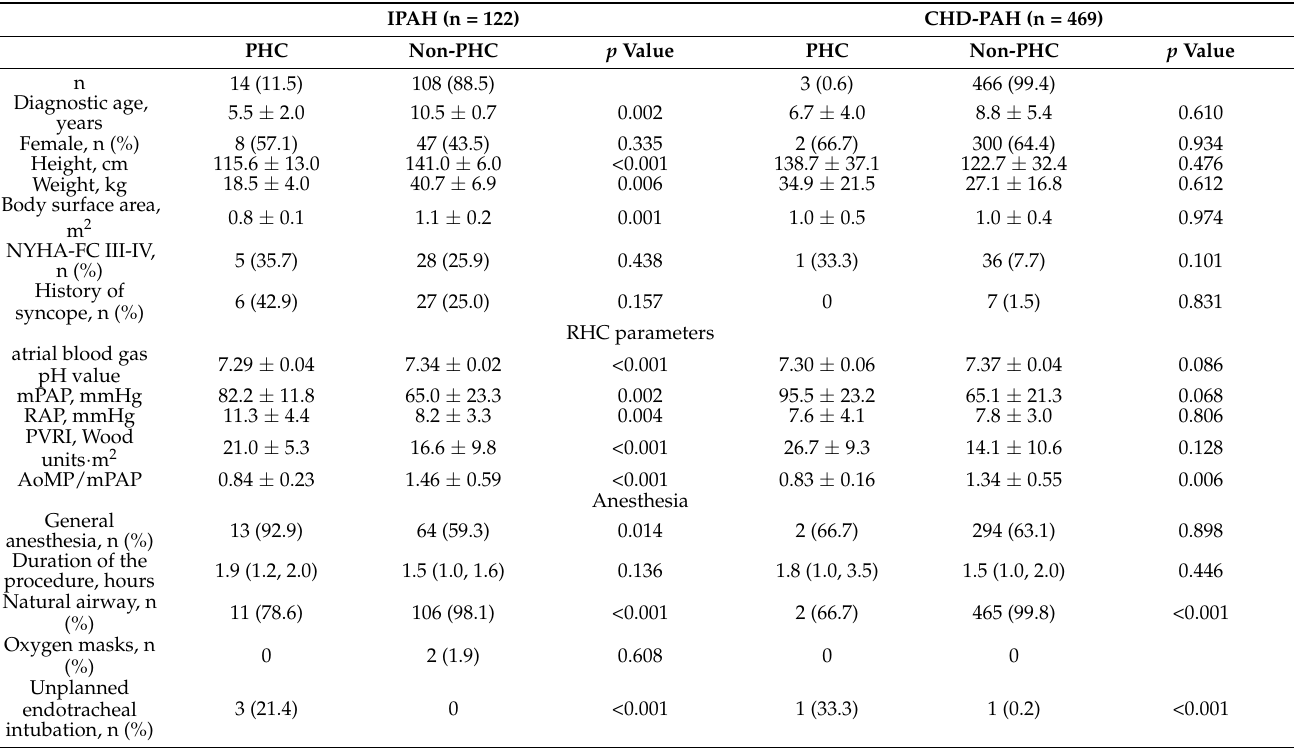
Table 3. Clinical and hemodynamic characteristics in IPAH and CHD-PAH patients with PHC compared with non-PHC